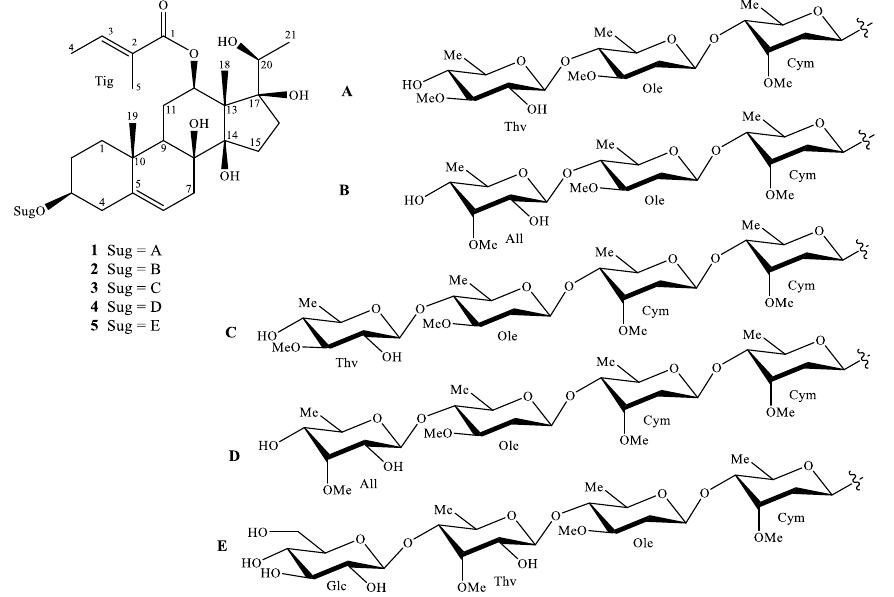
Figure 1. Chemical structures of compounds of 1 – 5 .